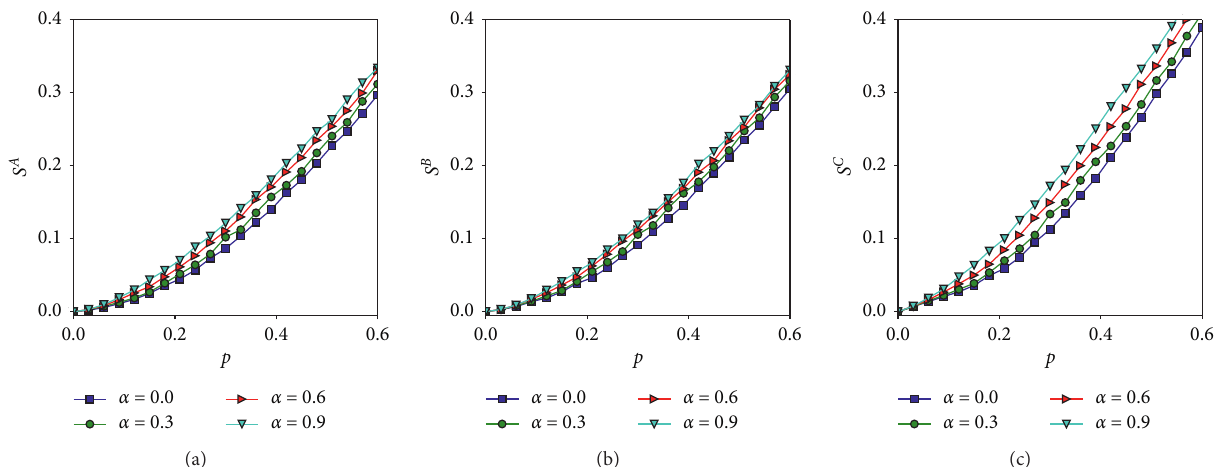
Figure 6: Percolation in multilayer empirical networks. The system consists of the three layers of networks A, B, and C which represent three major carriers: American Airlines (AA), Delta Air Lines (DL), and United Airlines (UA), respectively. (a–c) The sizes of the giant components of the network layers A , B , and C as functions of p for different values of α , respectively. The data points are the result of averaging over 1000 statistical realizations. (a) AA. (b) DL. (c)